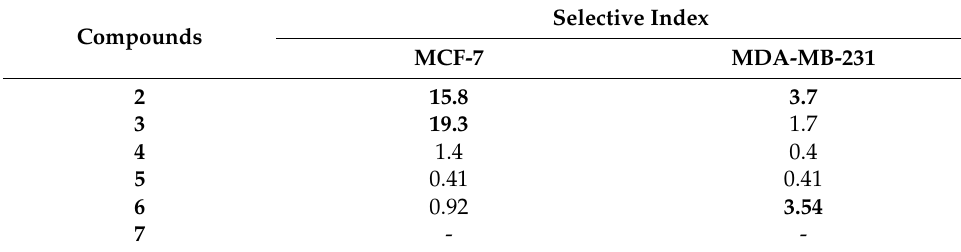
Table 3. Determination of selective index